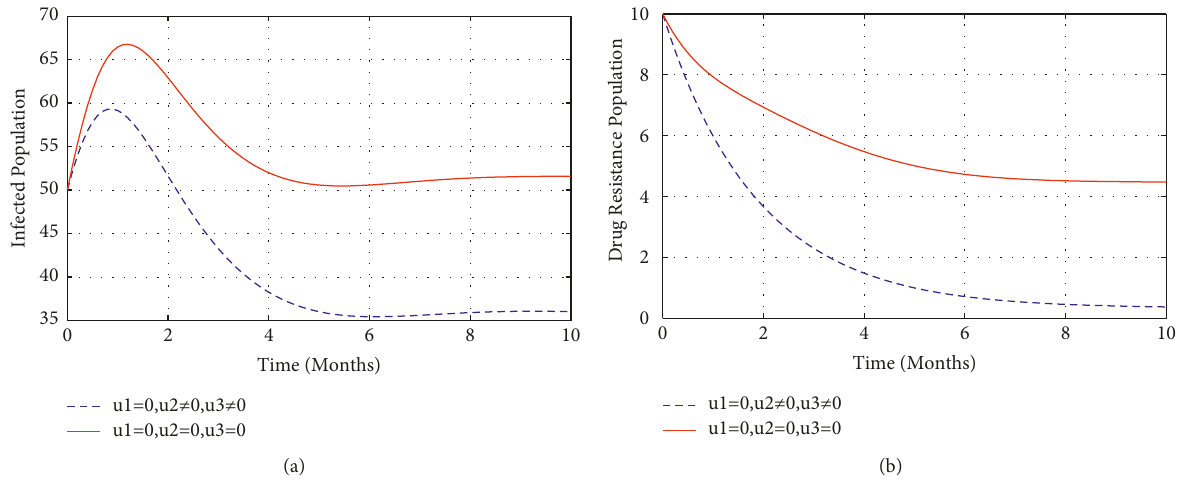
Figure 7: Impact of treatment of infectious and drug resistance on infectious and drug resistance